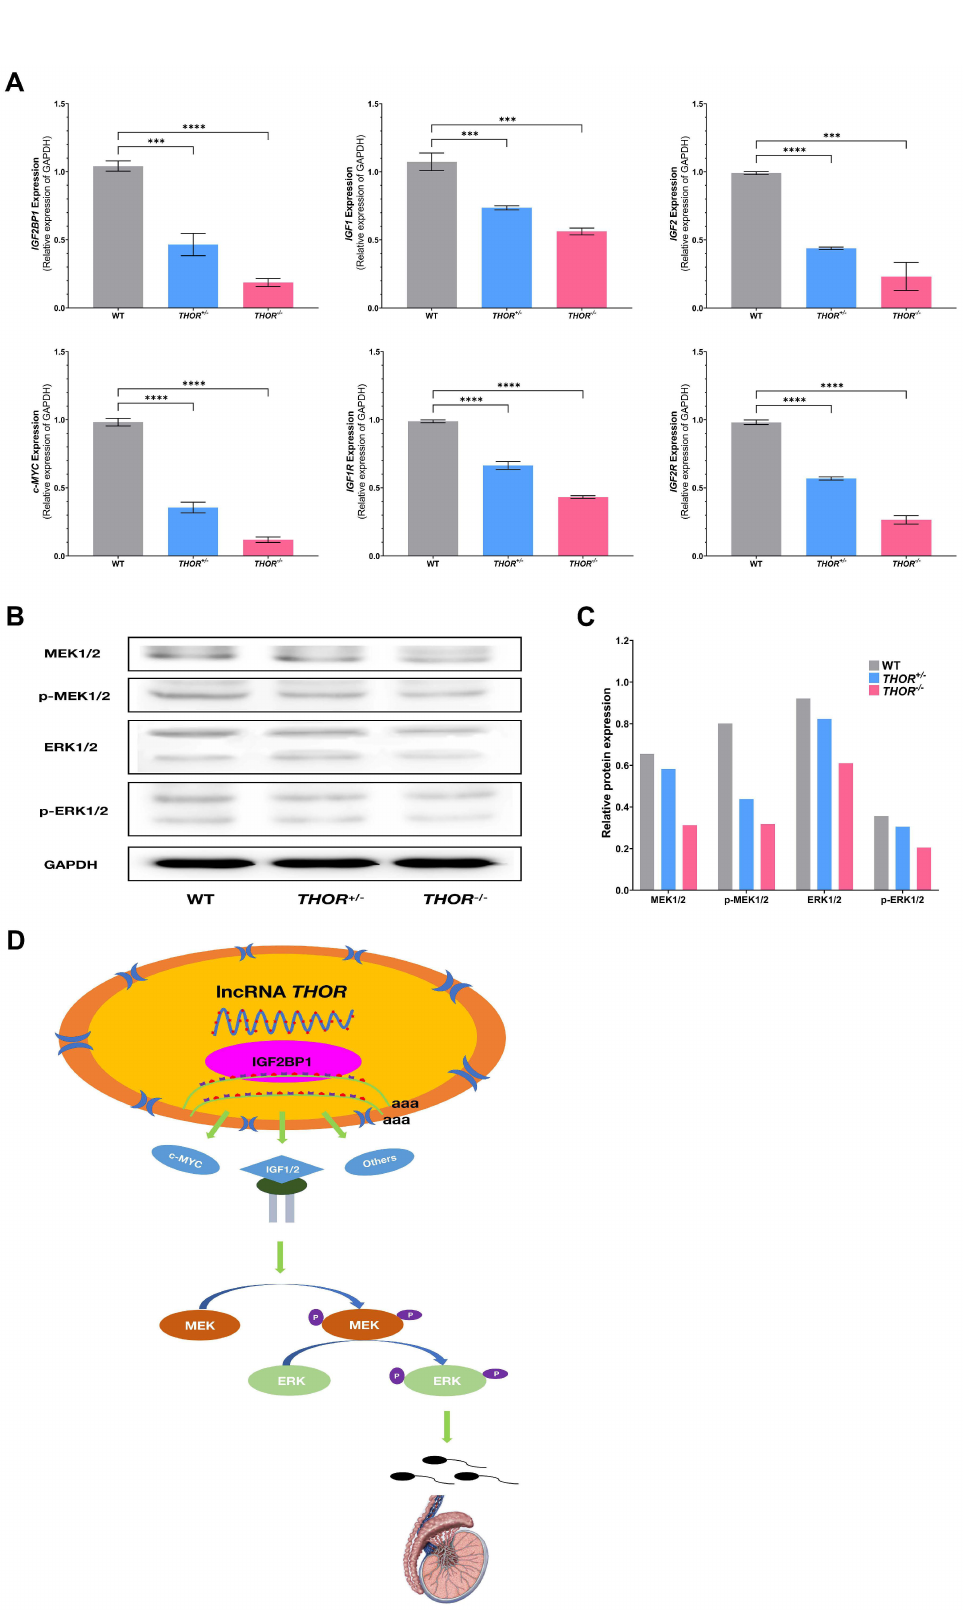
Figure 6. THOR deficiency affects sperm development. ( A ) Effect of THOR deficiency on the relative mRNA expression levels of target genes as determined by qRT-PCR. *** indicates p ≤ 0.001 as determined by a t -test, and **** indicates p < 0.0001 as determined by a t- test. The data are shown as the mean ± SD from three independent experiments. ( B ) Western blot analysis of testicular tissues from THOR -deficient mice. ( C ) Semiquantitative analysis of protein expression. ( D ) The mechanism of the effect of THOR on testicular and sperm